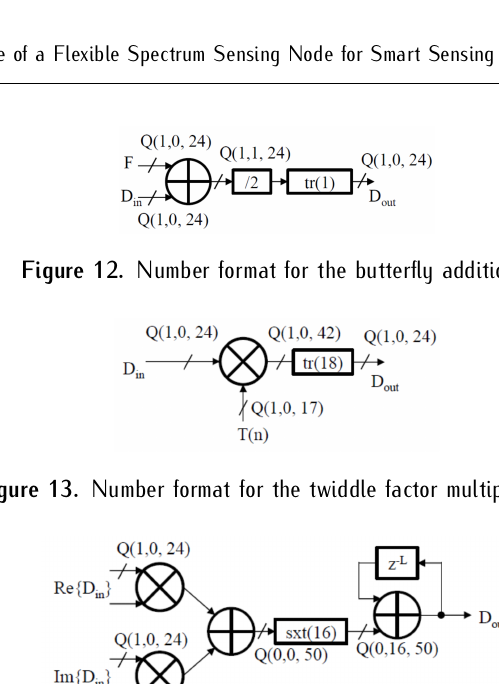
Figure 10. Software model test on a single tone, 14-bit ADC.